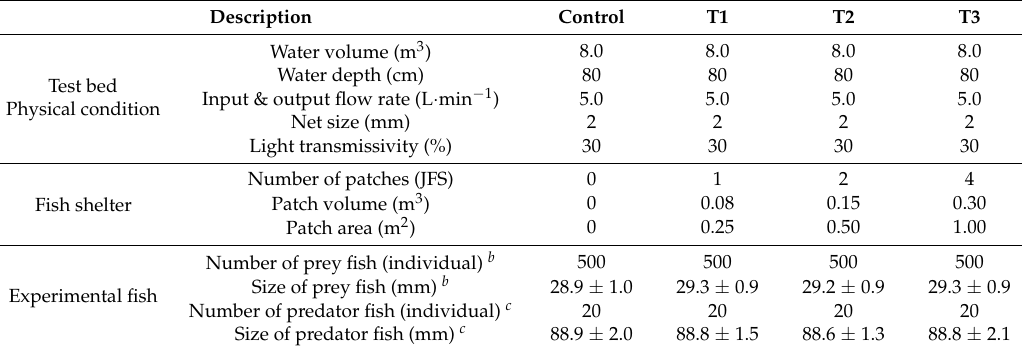
Table 1. Experimental design and operating conditions of large-scale mesocosm experiments between August 2011 and May 2012 a . Description